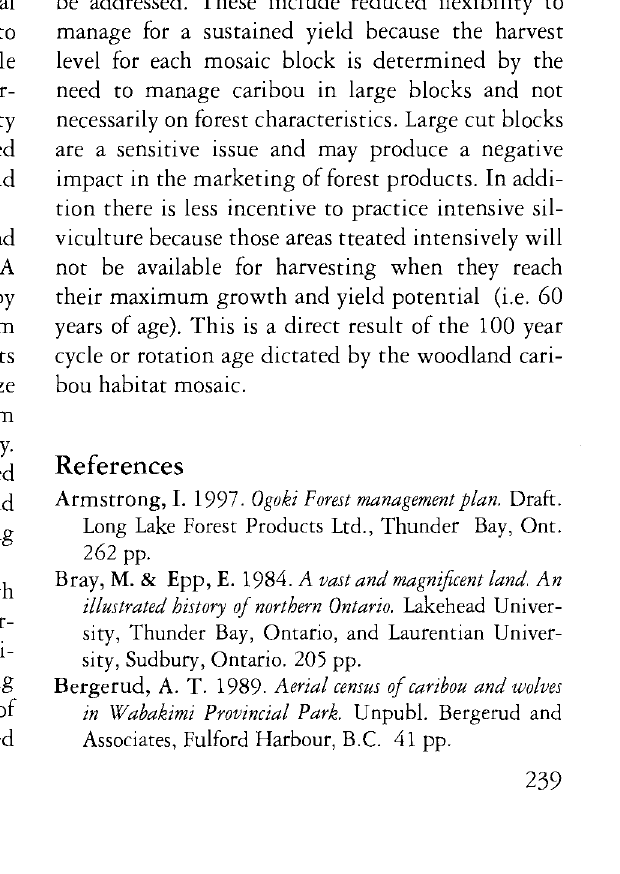
Fig. 2. Location of 50 mosaic harvest blocks within the Ogoki-Nakina North Forests of northwestern Ontario. Shaded blocks represents the pattern of forest logging disturbance after 40